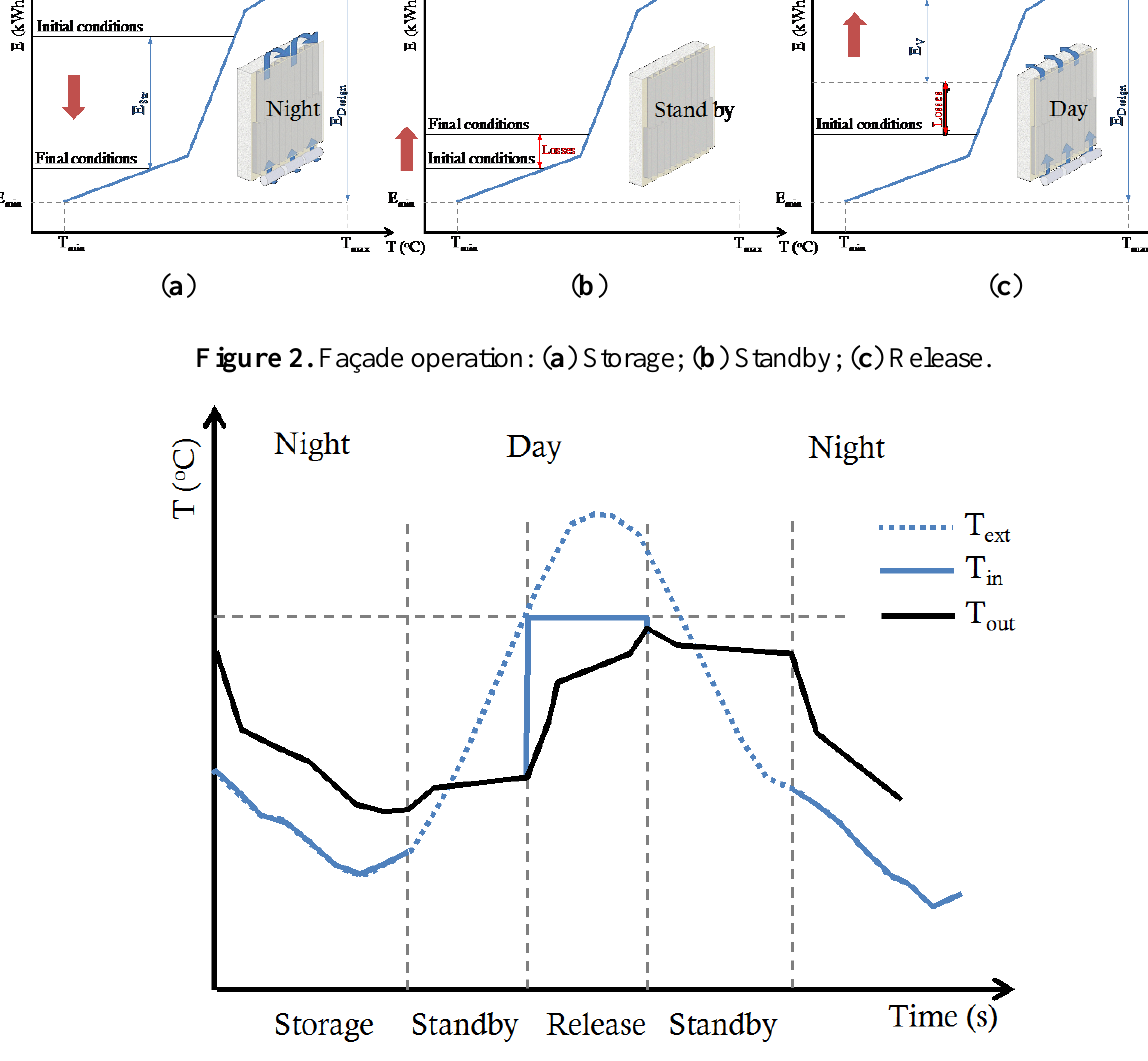
Figure 3. Daily façade operation